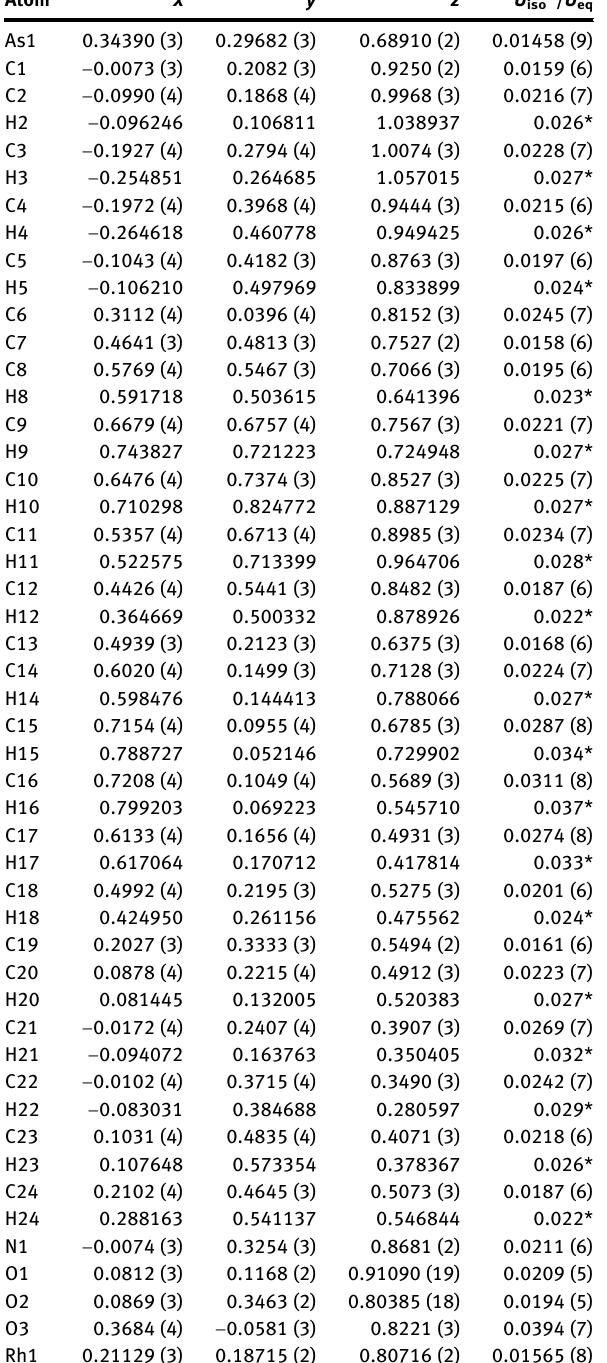
Table  : Fractional atomic coordinates and isotropic or equivalent isotropic displacement parameters (Å 